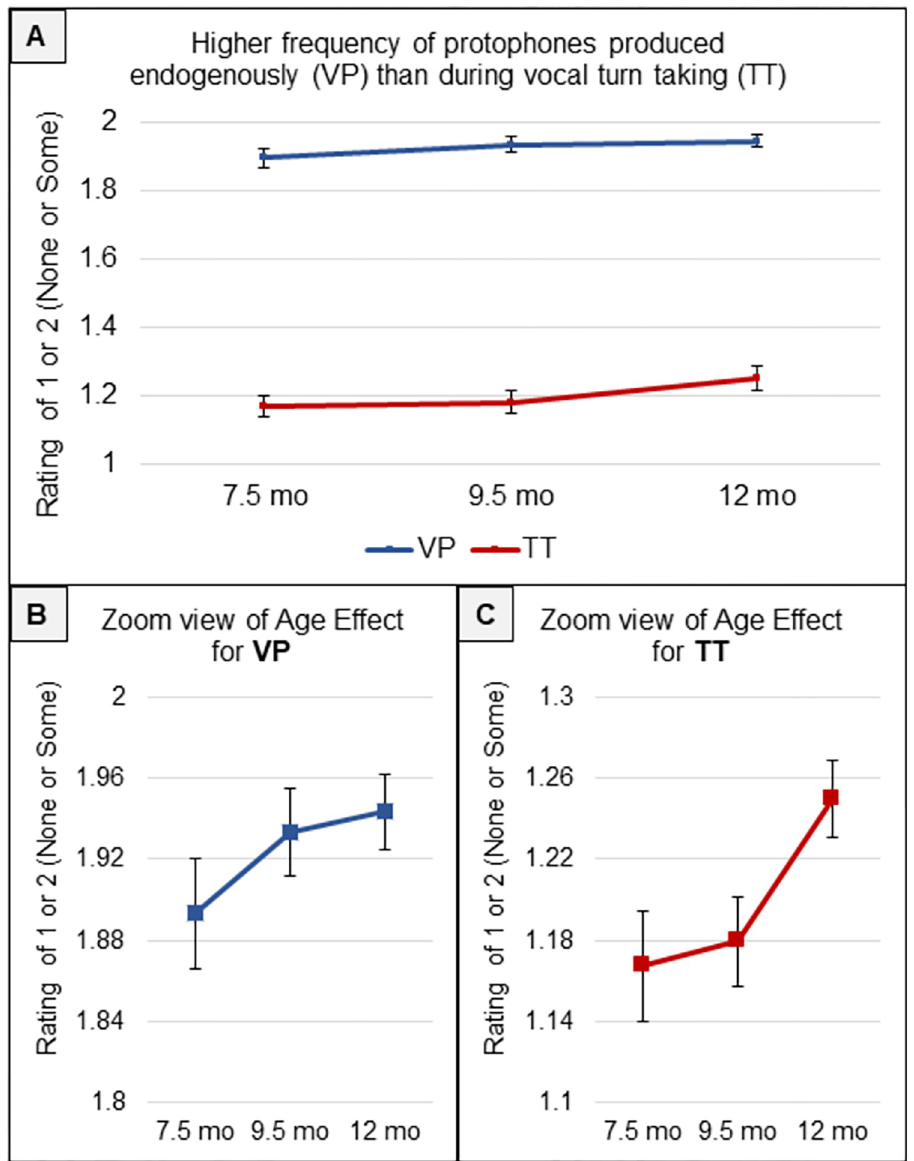
Fig 1. Amounts of VP and TT. A. The coders indicated that at all three Ages, the amount of VP for the 40 infants was much higher than the amount of TT. In the display, the scale has been converted so that 1 indicates No VP or TT in a coded segment, while 2 indicates Some VP or TT (any coded value from 2–5) occurred within a segment. On average, VP was deemed to have occurred considerably more than half the time during the segments, while TT was deemed to have occurred far less than half the time. The error bars are 95% confidence intervals. B. Zooming in so that mean differences and error bar information are more visible shows that VP occurred more often at 9.5 and 12 mo than at 7.5 mo. C. Zooming in also shows that TT occurred more often at 12 mo than at the younger